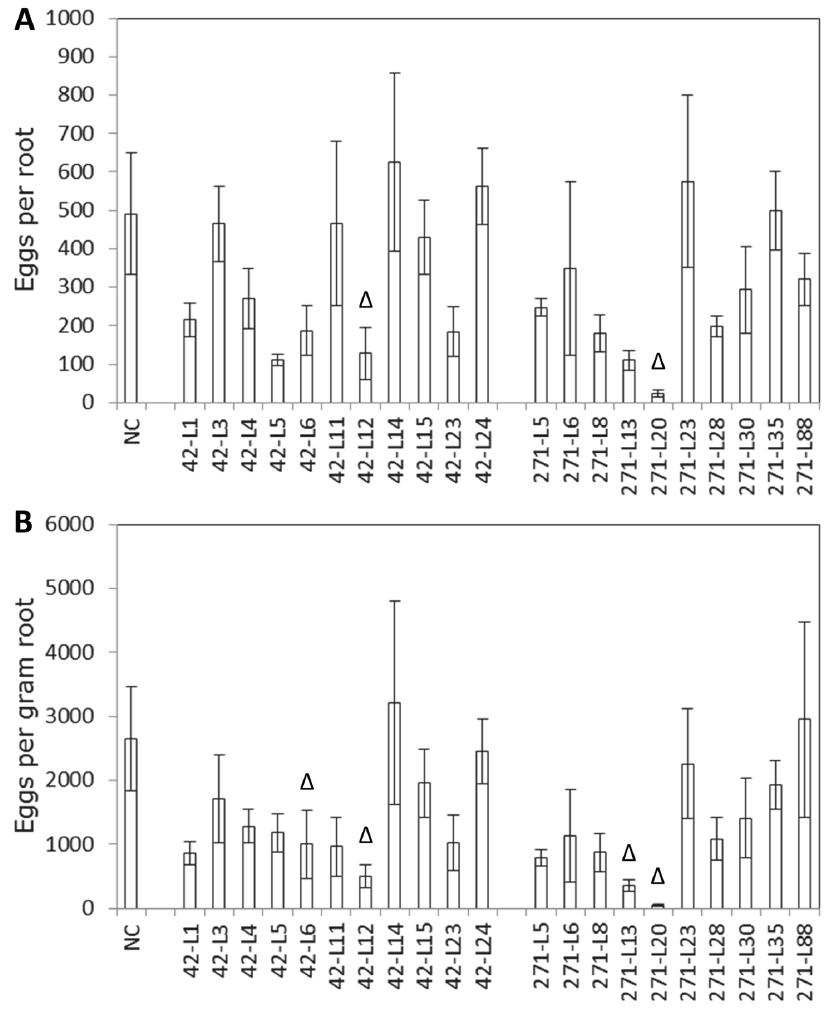
Figure 2. Reproduction of root-knot nematodes on 16D10 transgenic hairy root lines. (A) Eggs per hairy root. (B) Eggs per gram hairy root. NC is the negative control ( pART27 0). 42-L1 and 271-L5 represent the abbreviations of pART27-42 line 1 and pART27-271 line 5, respectively. Bars represent the means 6 SEs observed from individual hairy root lines. Bars (hairy root lines) with ‘‘ D ’’ were significantly different from the negative control at P , 0.01, on the basis of log 10 transformed data. Data for this figure were provided in Table S1.